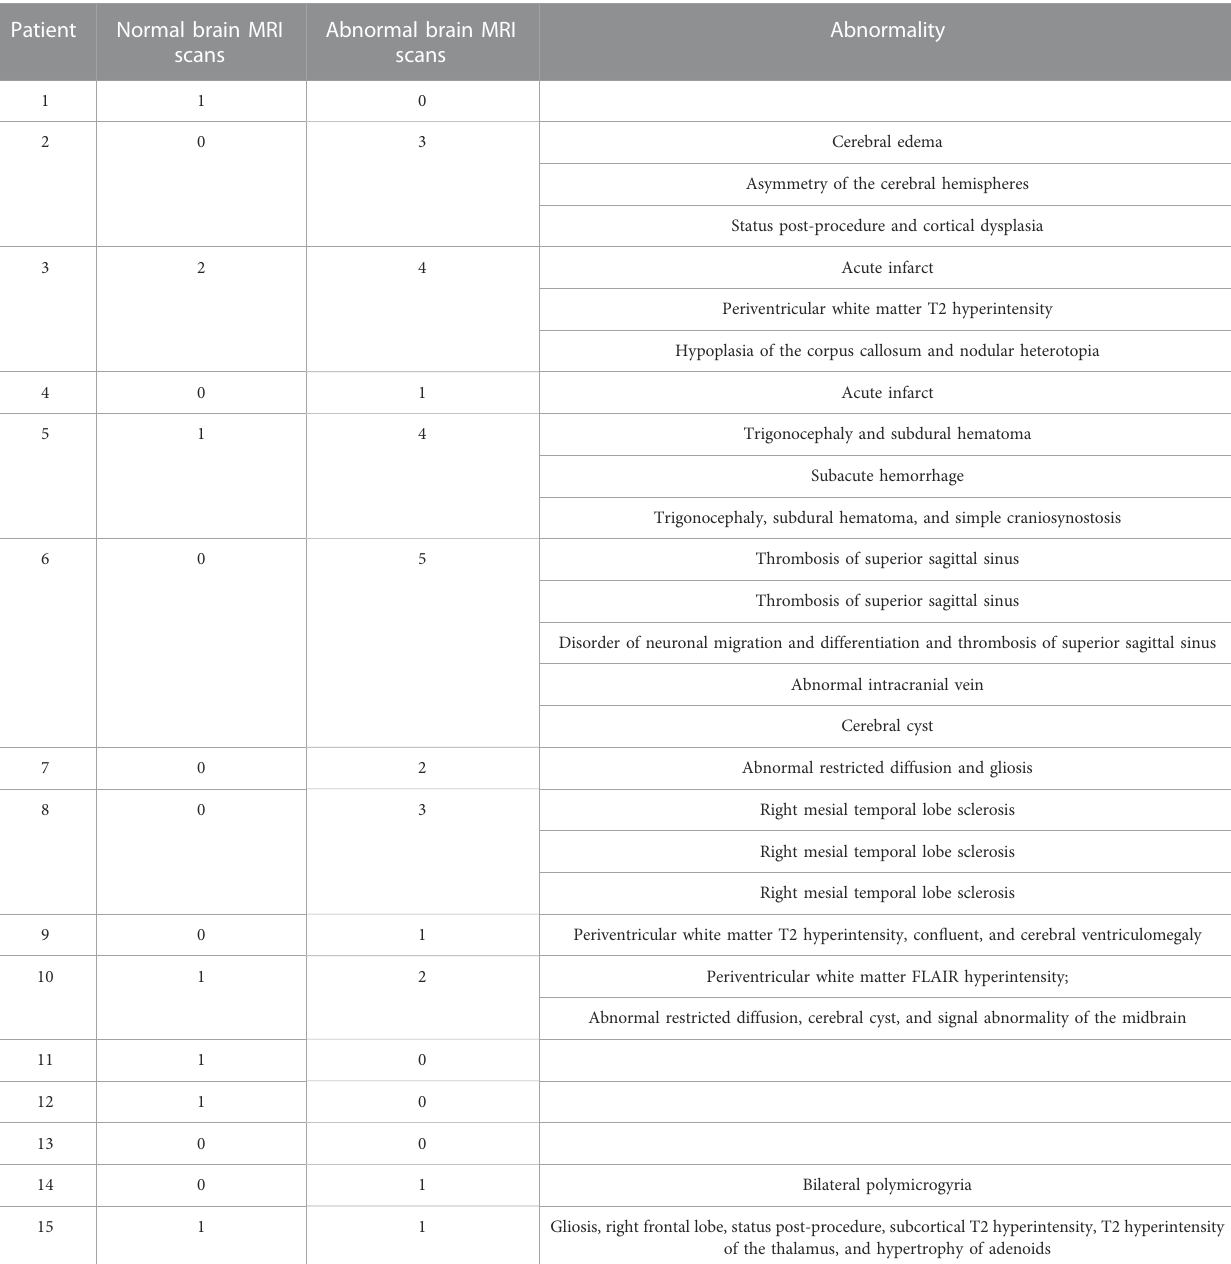
TABLE 5 MRI report summary. All MRI reports extracted from the medical records and the number of normal and abnormal scans with short description of each abnormal result is listed for each